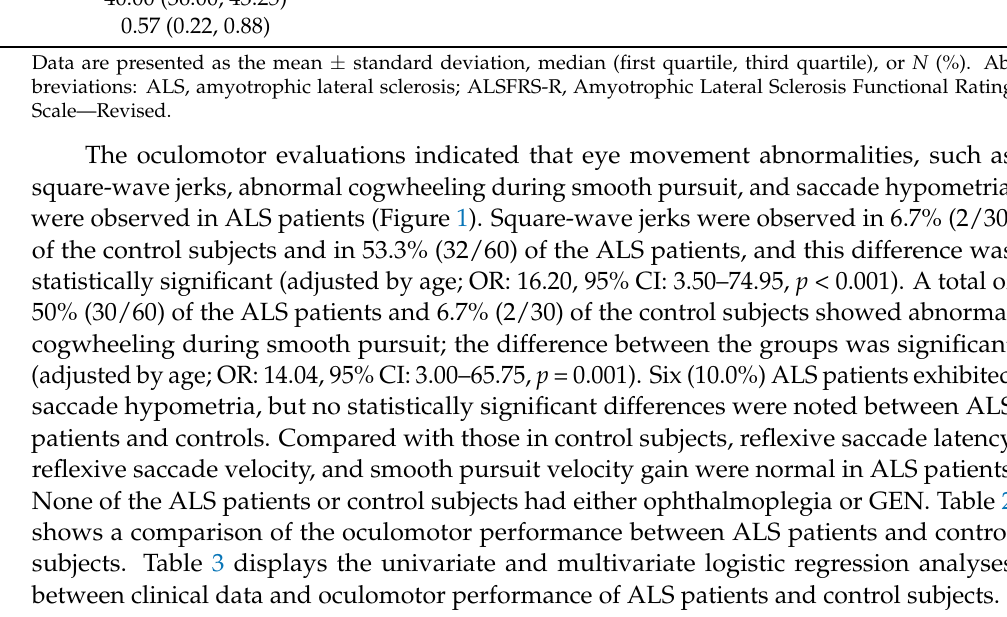
Table 2. Comparison of oculomotor performance between ALS patients and control